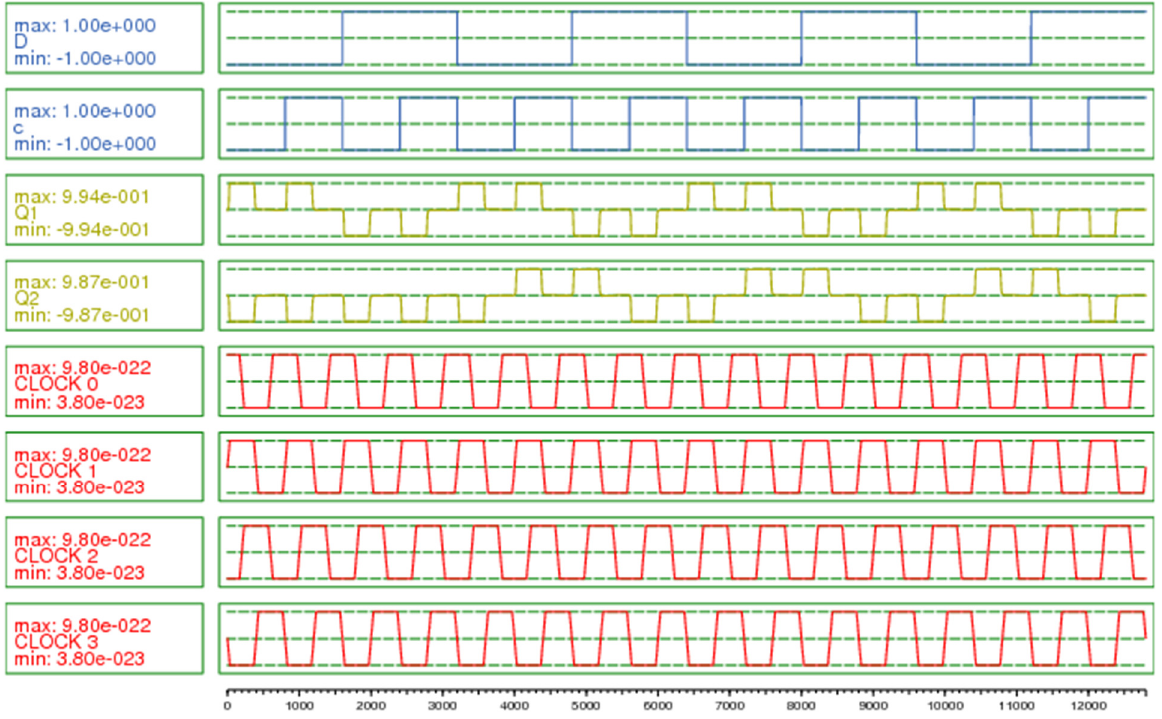
Figure 17. Simulation Graph of the 2-bit SIPO shift register.